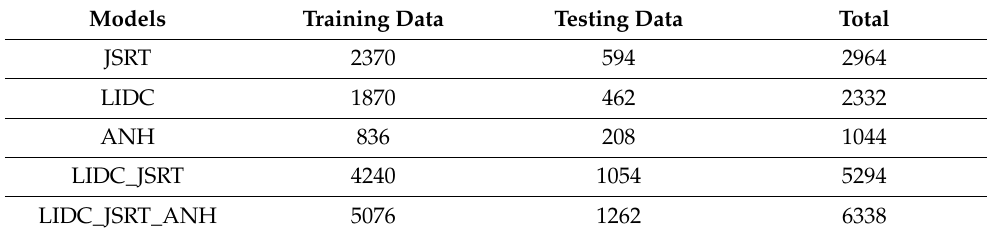
Table 1. The number of images used for training and testing of each model.